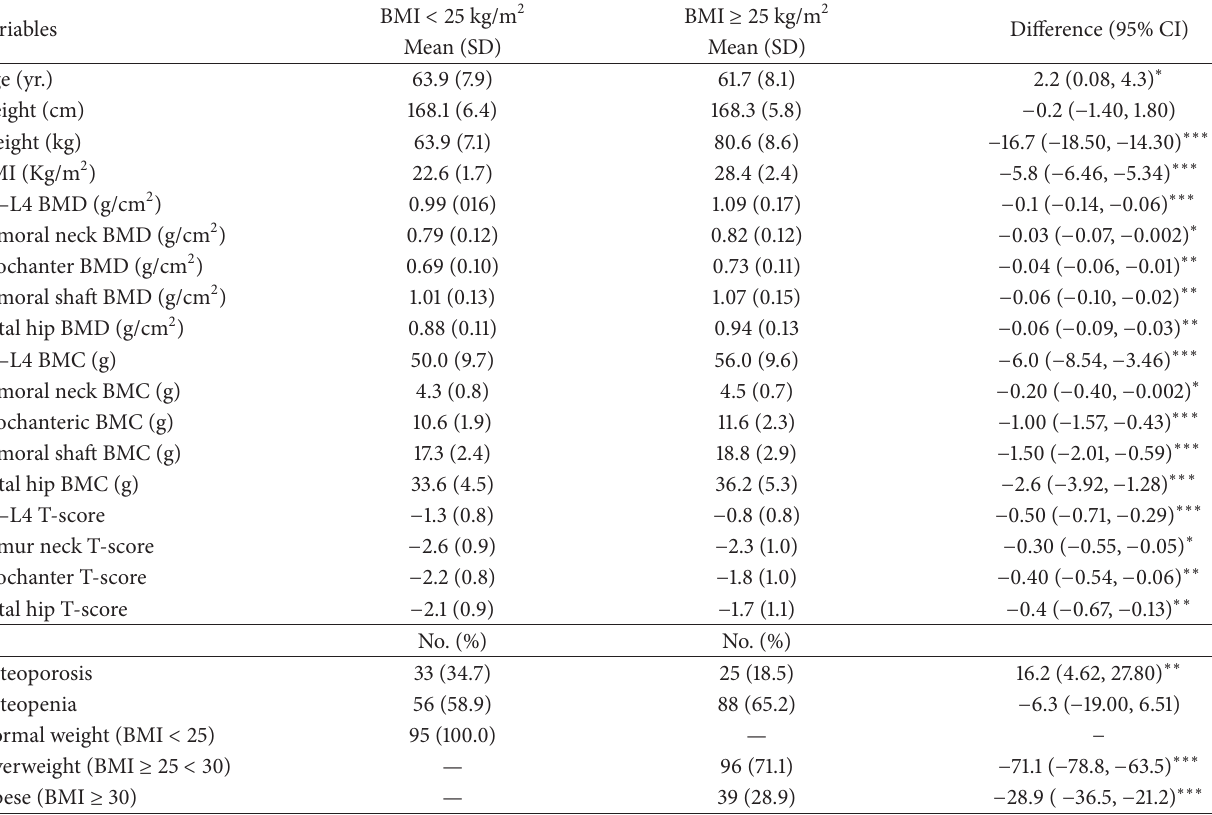
Table 1: Age, age-adjusted means (SD), and proportions of selected anthropometric and densitometric measures between 95 men with body mass index (BMI) < 25 kg/m 2 and 135 men who had BMI ≥